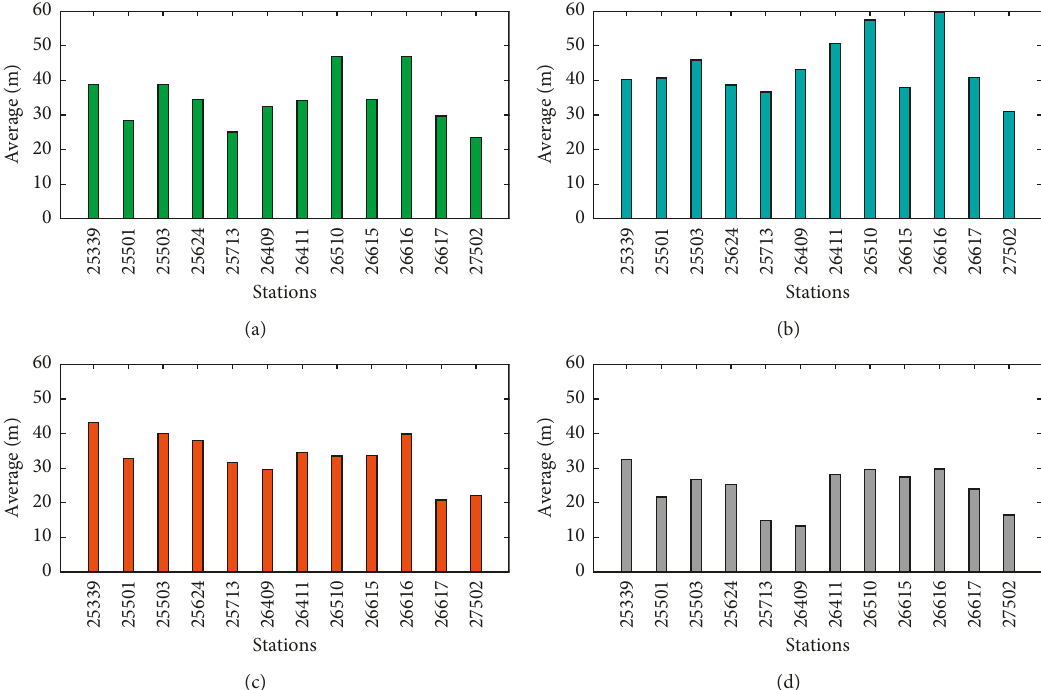
Figure 10: Seasonal average thickness (m) distributions of surface ducts at 12 stations in Alaska: (a) spring; (b) summer; (c) autumn; (d)